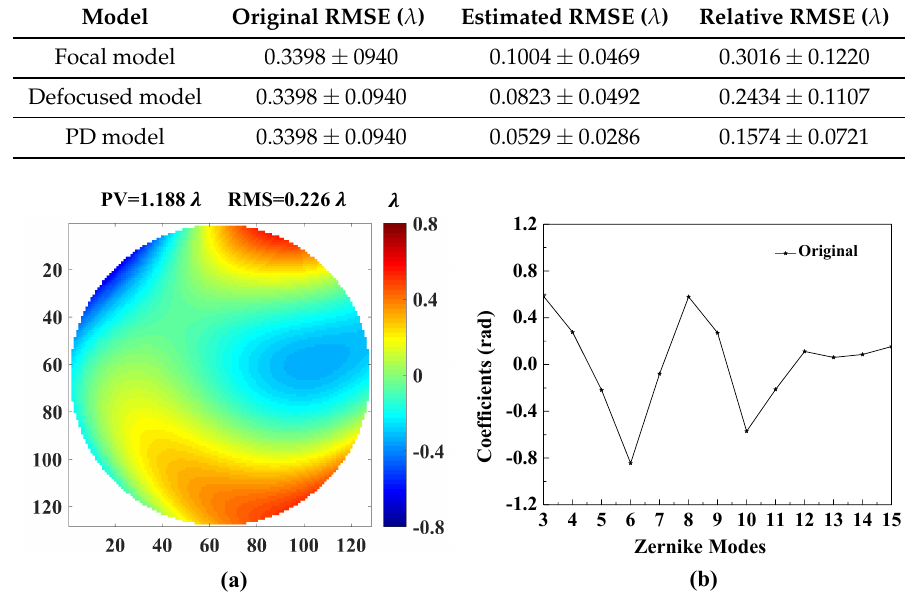
Figure 8. A sample of test data set. ( a ) The original wavefront and ( b ) the original Zernike coefficients. The unit of original wavefront is λ . The unit of original Zernike coefficients is rad.